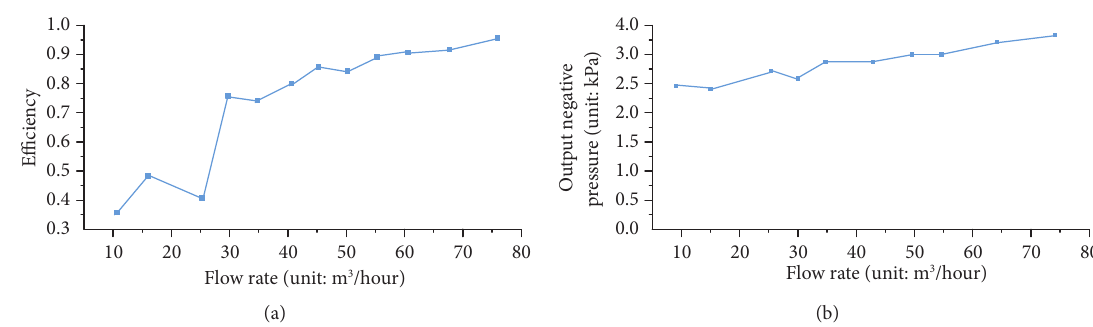
Figure 9: Efficiency and pressure output of pressure generator. (a) Efficiency of pressure generator. (b) Pressure output of pressure generator.